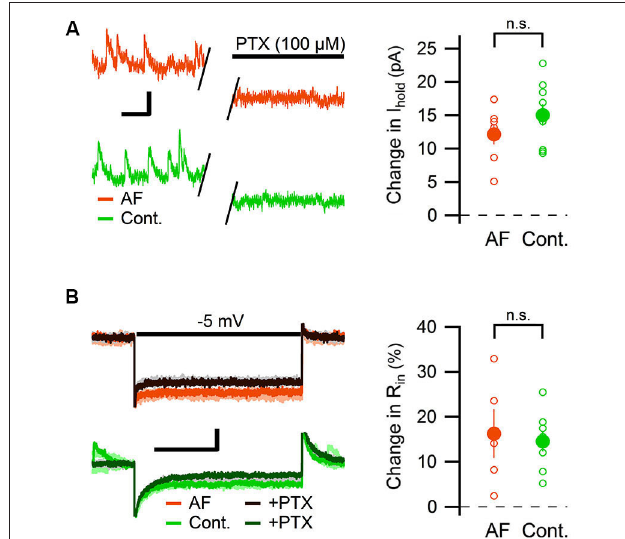
FIGURE 6 | AF-16 does not enhance tonic GABAergic transmission in CA1 pyramidal neurons. (A) Diagram showing the effect of PTX on the holding current in CA1 pyramidal neurons incubated in AF-16 ( n = 7) and control ( n = 9). Open circles represent the individual experiments while the filled circles represent the average ( ± s.e.m.) values. On the left are representative traces before and after application of PTX, scale bar represents 10 pA and 250 ms. (B) Diagram showing the effect of PTX on the input resistance in CA1 pyramidal neurons incubated in AF-16 ( n = 5) and control ( n = 8). Open circles represent the individual experiments while the filled circles represent the average ( ± s.e.m.) values. On the left are representative traces during a − 5 mV test pulse before (orange/light orange and green/light green colors for AF and control, respectively) and after (dark brown/gray and dark green/gray colors for AF and control, respectively) application of PTX, scale bar represents 30 pA and 75 ms. n.s. not significant ( p >